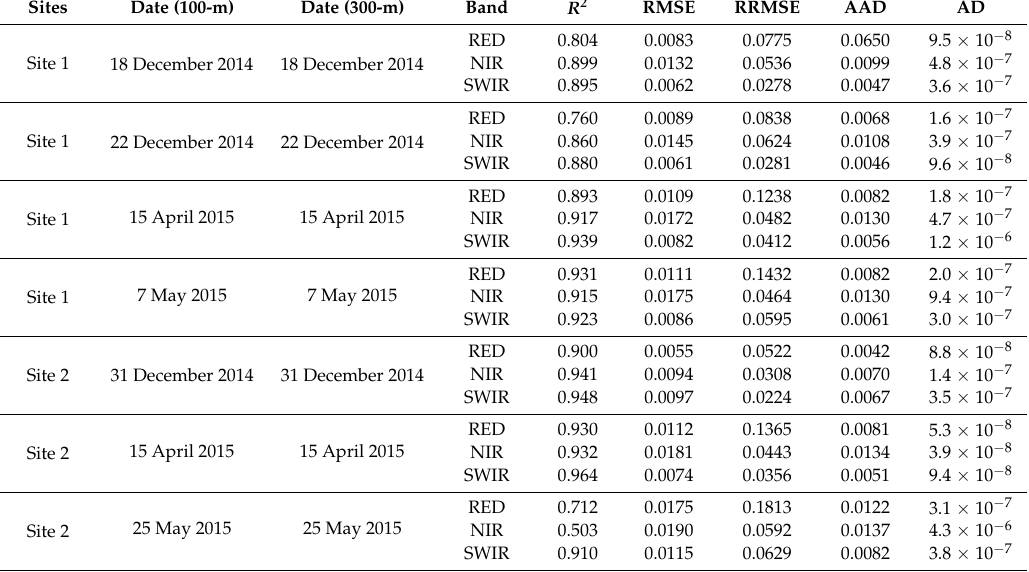
Table 5. Results for the pixel-based, band-by-band accuracy assessment of the referenced PROBA-V 100-m reflectance compared to the ESTARFM predicted reflectance.